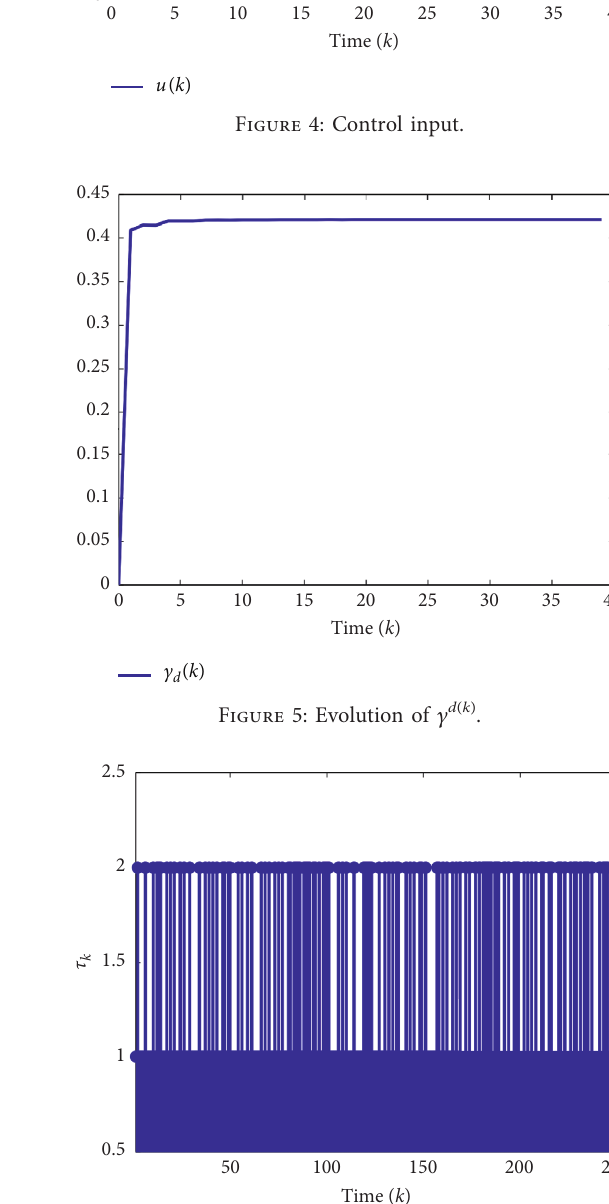
Figure 1: State mode.